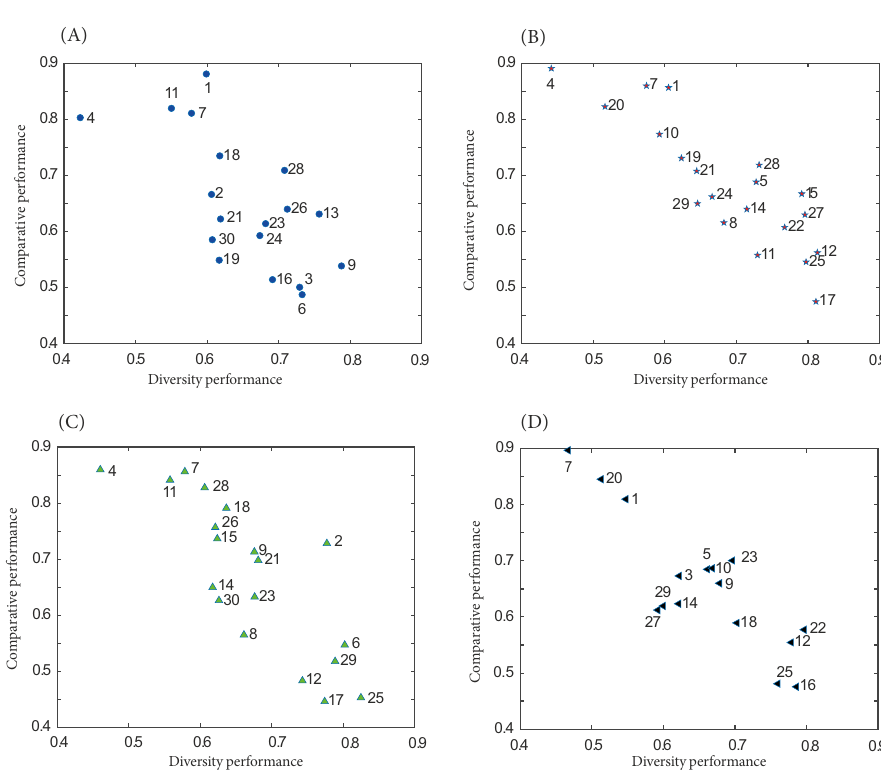
Figure 3. Comparative and diversity performance for the four components Note: A – intake air pressure sensor; B – oil injection nozzle; C – oxygen sensor; D –